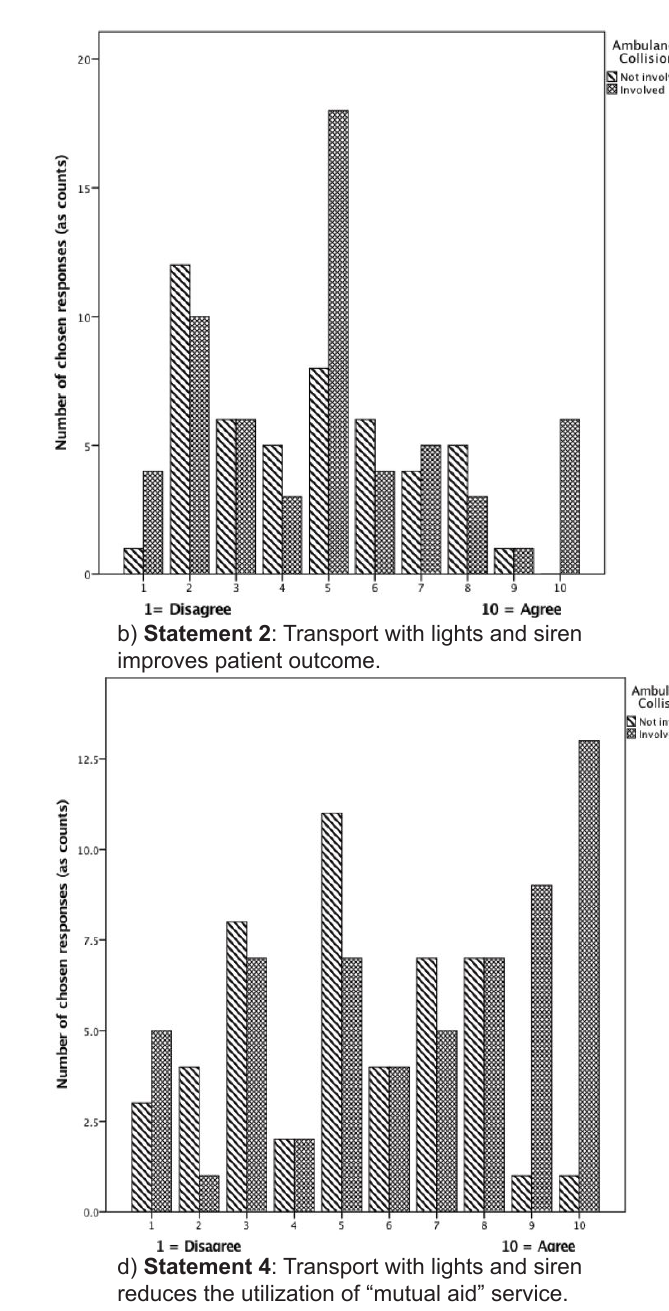
Figure 2. Distribution of responses from emergency medical services providers separated by whether they had experienced a prior ambulance